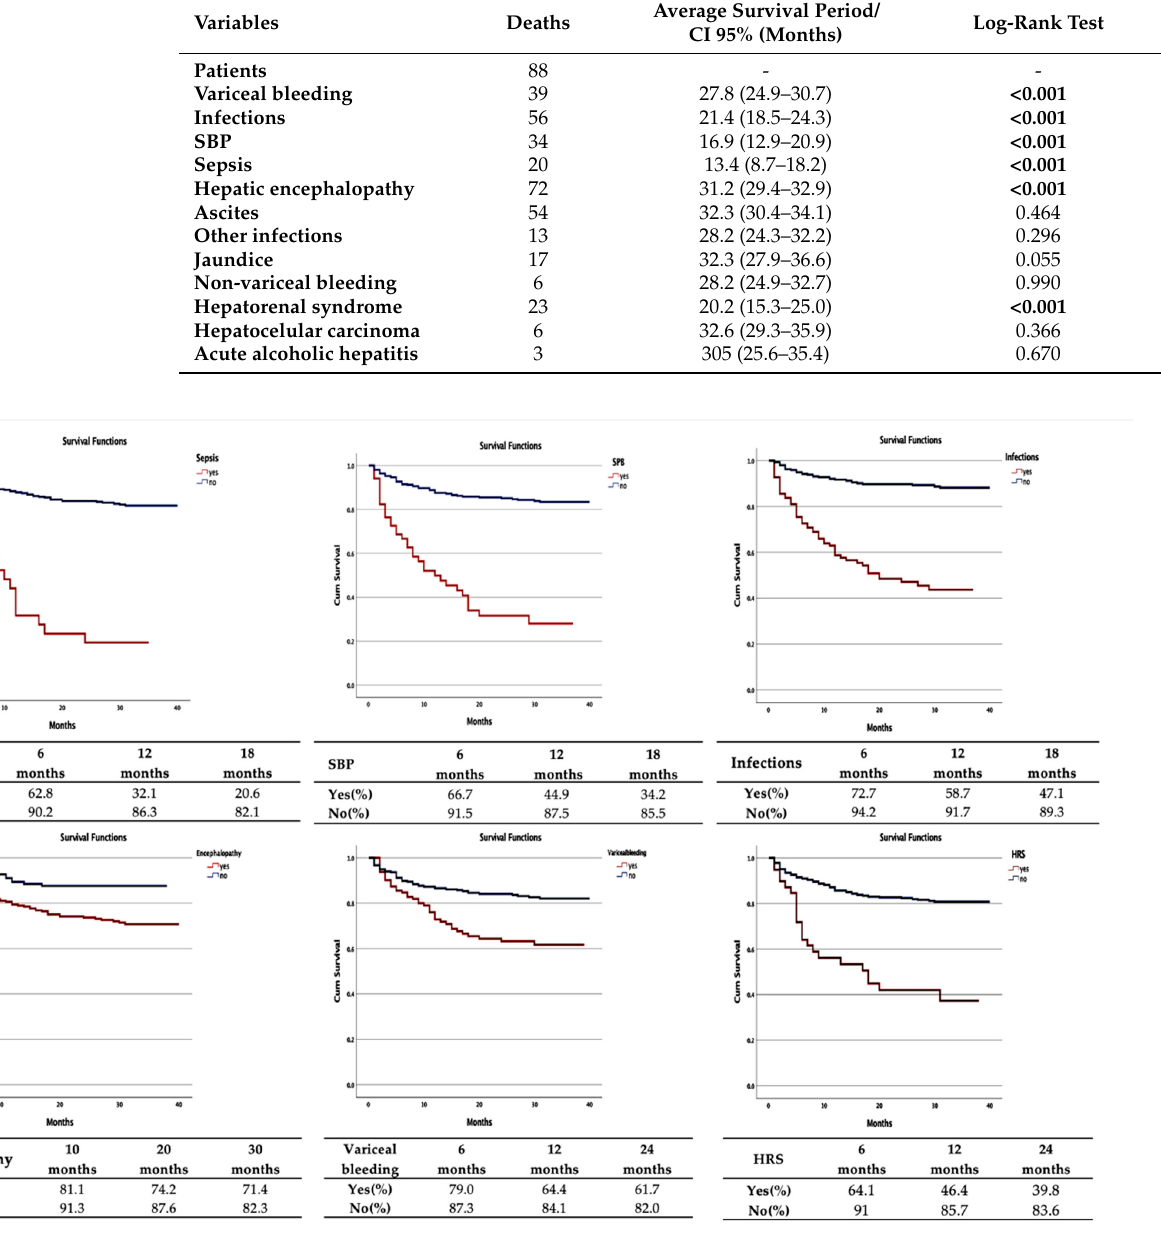
Figure 4. Evolution of alcoholic liver cirrhosis in patients with multiple admissions—Kaplan–Meier curve. SBP: spontaneous bacterial peritonitis HRS: hepatorenal syndrome.